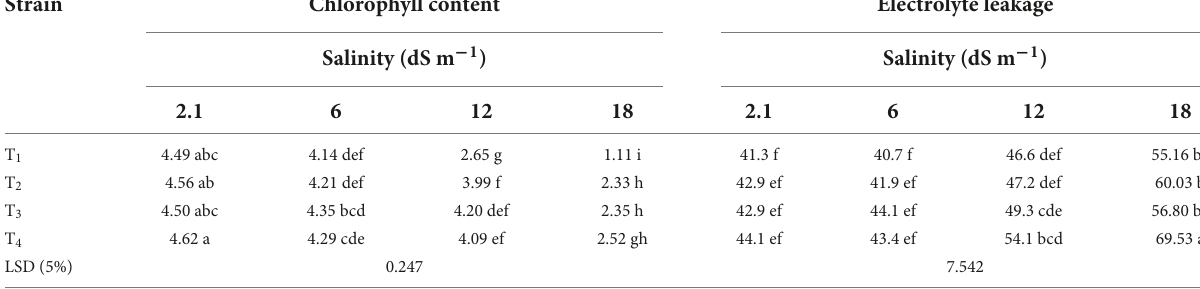
TABLE 6 Effect of inoculation with multi-strain bacterial consortium on chlorophyll content (mg/g fresh weight) and membrane stability index of wheat at different salinity levels in a pot trial. Strain